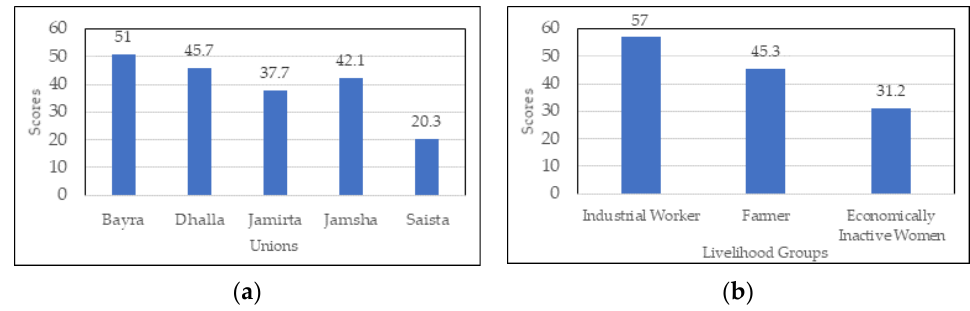
Figure 8. Score for c apacity component for: ( a ) 5 unions; and ( b ) livelihood groups.